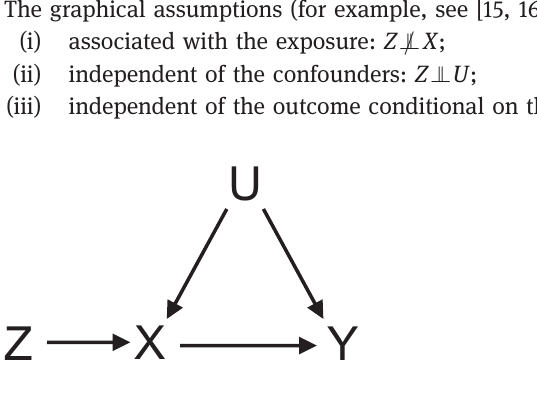
Figure 1: Directed acyclic graph of graphical instrumental variable